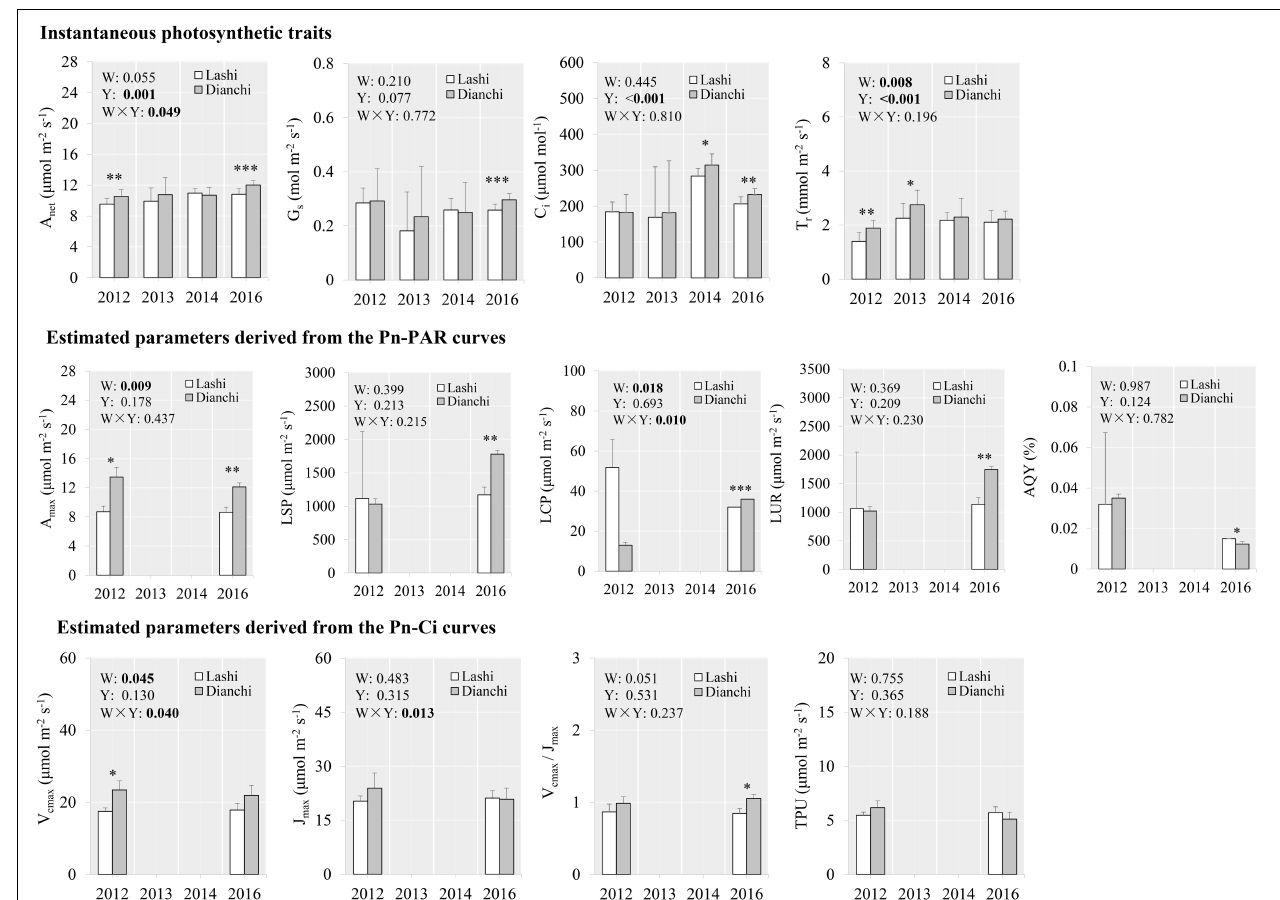
FIGURE 4 | Photosynthetic traits of S. tabernaemontani leaves between Dianchi and Lashi using the natural latitudinal gradient. Significance tests for warming ( W ), observed year ( Y ), and the interaction term ( W × Y ) under repeated-measures ANOVA are presented for each variable integrated across the different years ( p -values less than 0.05 are in bold). Within each year, variables that responded significantly to warming are indicated by asterisks ( ∗∗∗ p < 0.001; ∗∗ p < 0.01; ∗ p < 0.05). Error bars indicate standard deviations. P n -PAR and P n - C i curves were not determined in 2013 and 2014. See Figure 2 for descriptions of